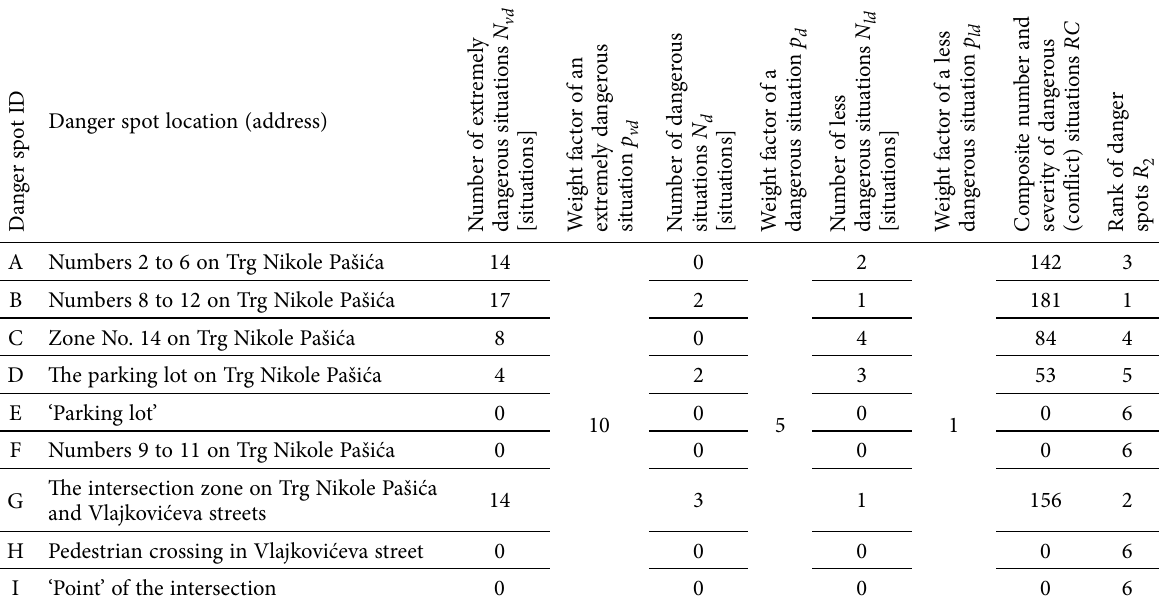
Table 2. Ranking danger spots based on the modified conflict technique (Vujanić et al. 2009b)